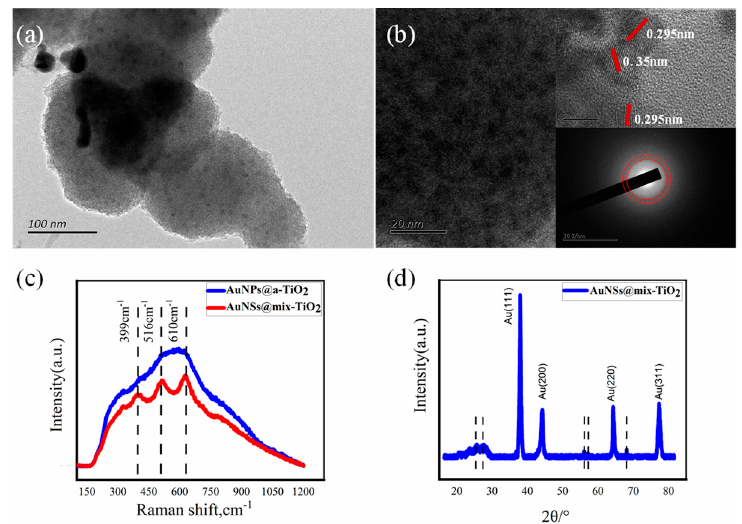
Figure 5. Morphology and characterization of Au nanostar and hybrid TiO 2 composites (AuNSs@mix-TiO 2 ) prepared by ETLAL. ( a , b ) HRTEM morphology characterization results, where the up inset in ( b ) shows the lattice spacing corresponding to the TiO 2 , and the down inset in ( b ) shows the electron diffraction pattern of TiO 2 in the selected region; ( c ) The Raman spectrum analysis of AuNPs@a-TiO 2 and AuNSs@mix-TiO 2 ; ( d ) The XRD patterns of AuNSs@mix-TiO 2